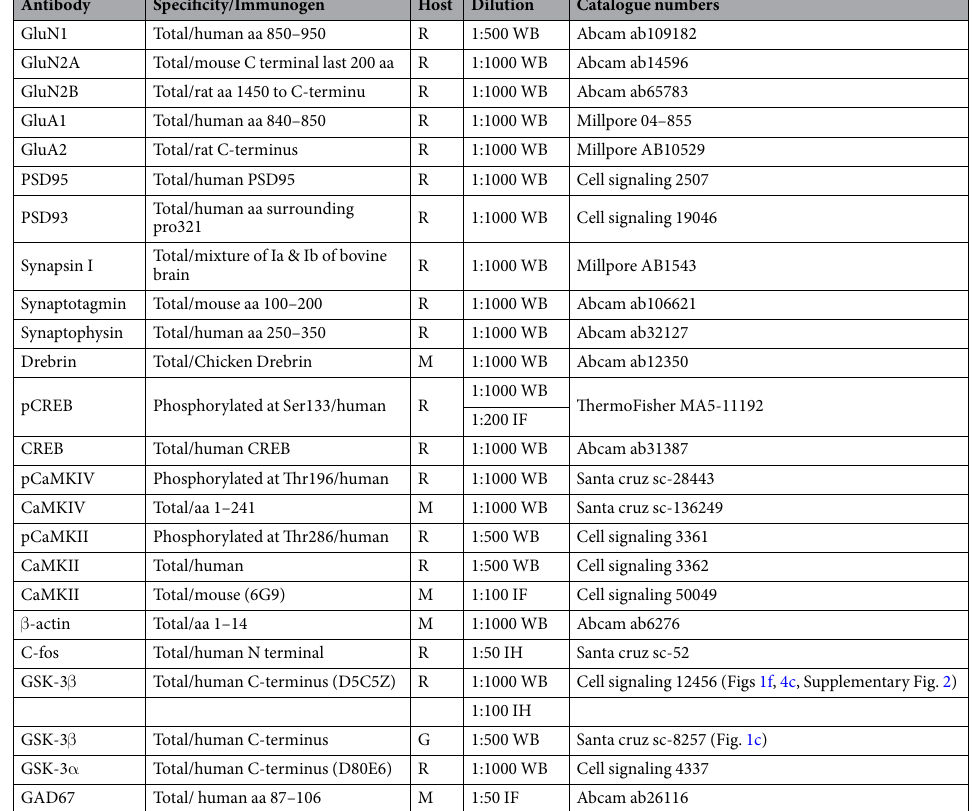
Table 1. Antibodies employed in the study. WB: Western blotting; IH: immunohistochemistry; IF: Immunofluorescence; aa: amino acid; M: mouse; R: rabbit; G: